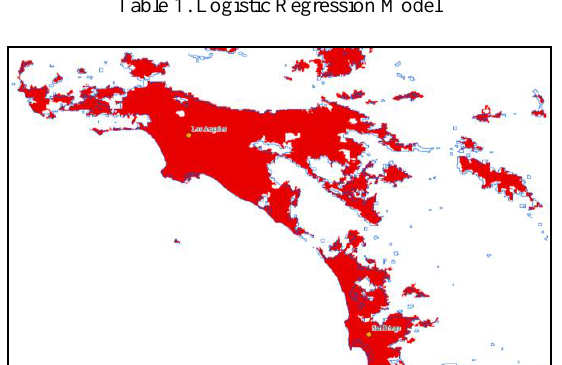
Figure 3. Highly Impacted Areas (intensity => 164) from satellite image (NASA, 2013) and Urban Areas in Southern California by the US Census Bureau. Figure 4. Areas highly impacted by nighttime lighting 5. The delimitation of the centers and peripheries of urban agglomerations is made by setting a threshold of nighttime light intensity that allows the inclusion of most of the centers and sub-centers, defined as the localities with a population over 50,000 inhabitants (according the criteria of the US Census Bureau to identify the metropolitan centers). This threshold corresponds approximately to a light intensity of established through the division into natural breaks